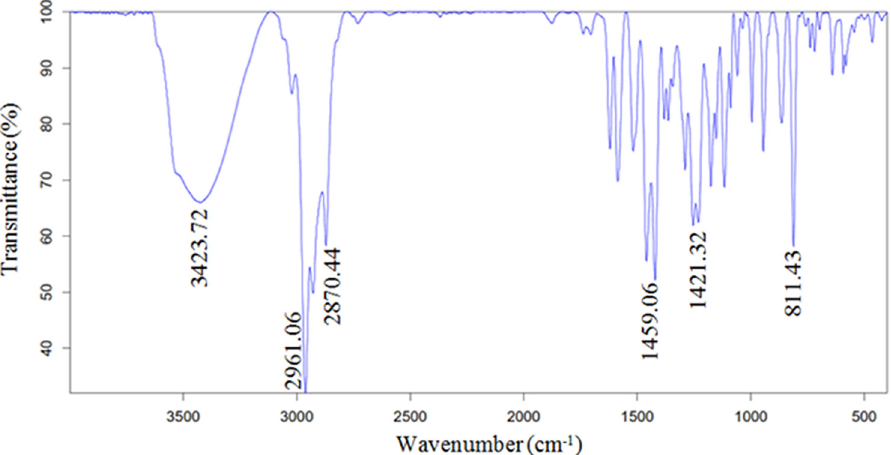
Figure 1: FTIR spectrum of thyme essential